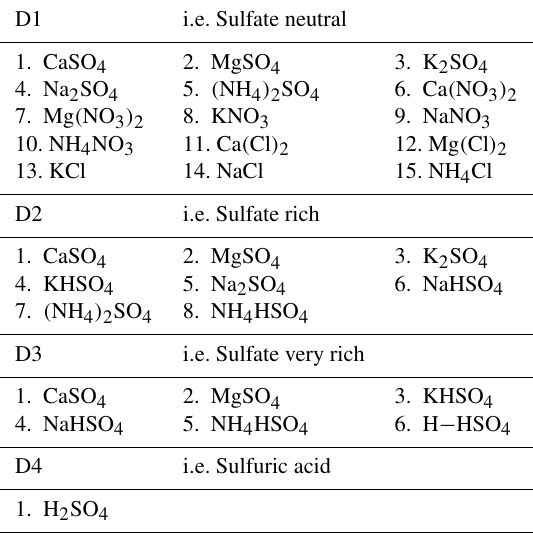
Table 3. Neutralisation reaction order for Table 2 (introduced in Sect. 2.3).